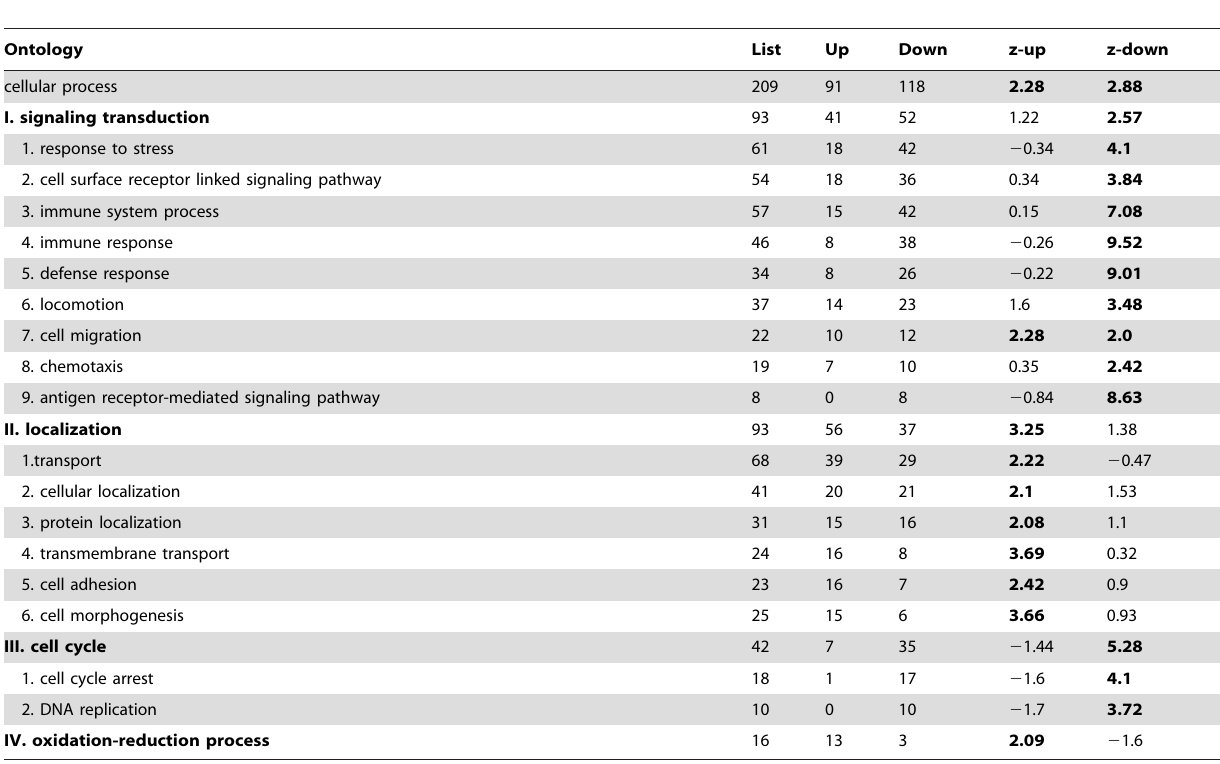
Table 3. Numbers of genes (total in list, up- and down-regulated) and associated z-scores . |2.0| in selected functional categories that contained significantly over-represented differentially expressed genes in naı¨ve aged-donor DCs compared to young.